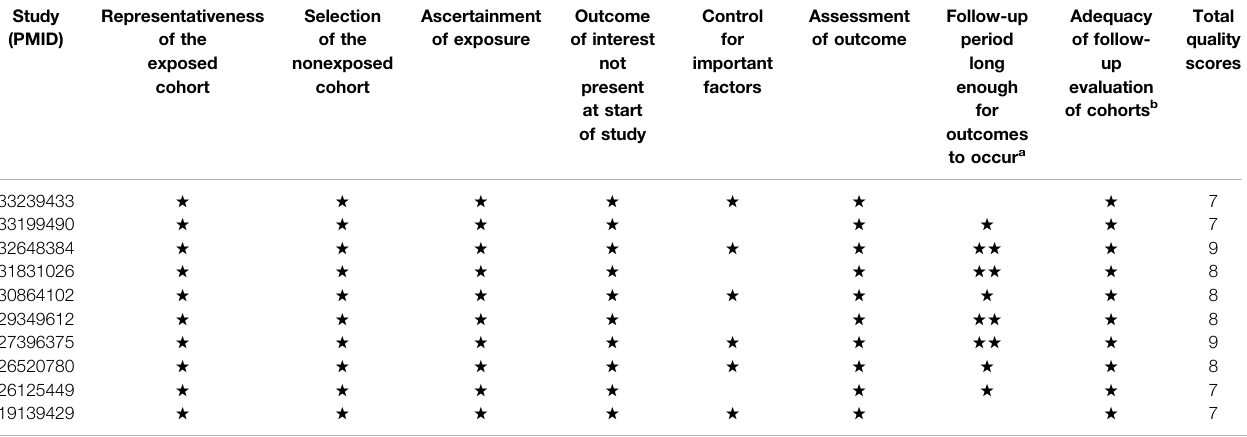
TABLE 2 | Methodologic quality of cohort studies included in the meta-analysis. Study Representativeness (PMID) of